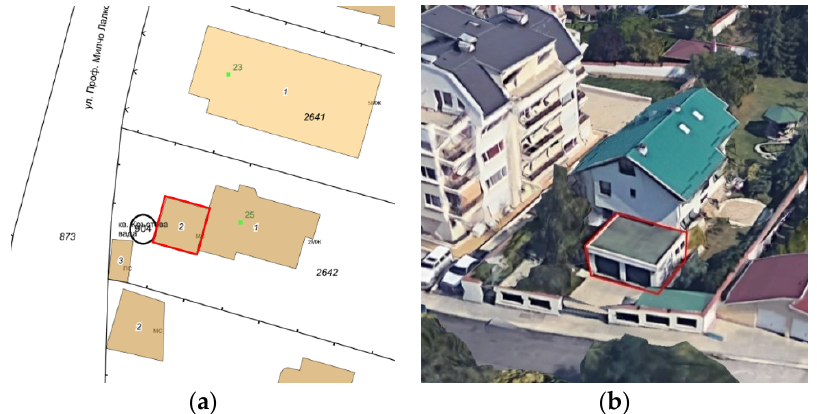
Figure 2. ( a ) The garage as a separate property in the cadastral map and ( b ) the garage shown in Google